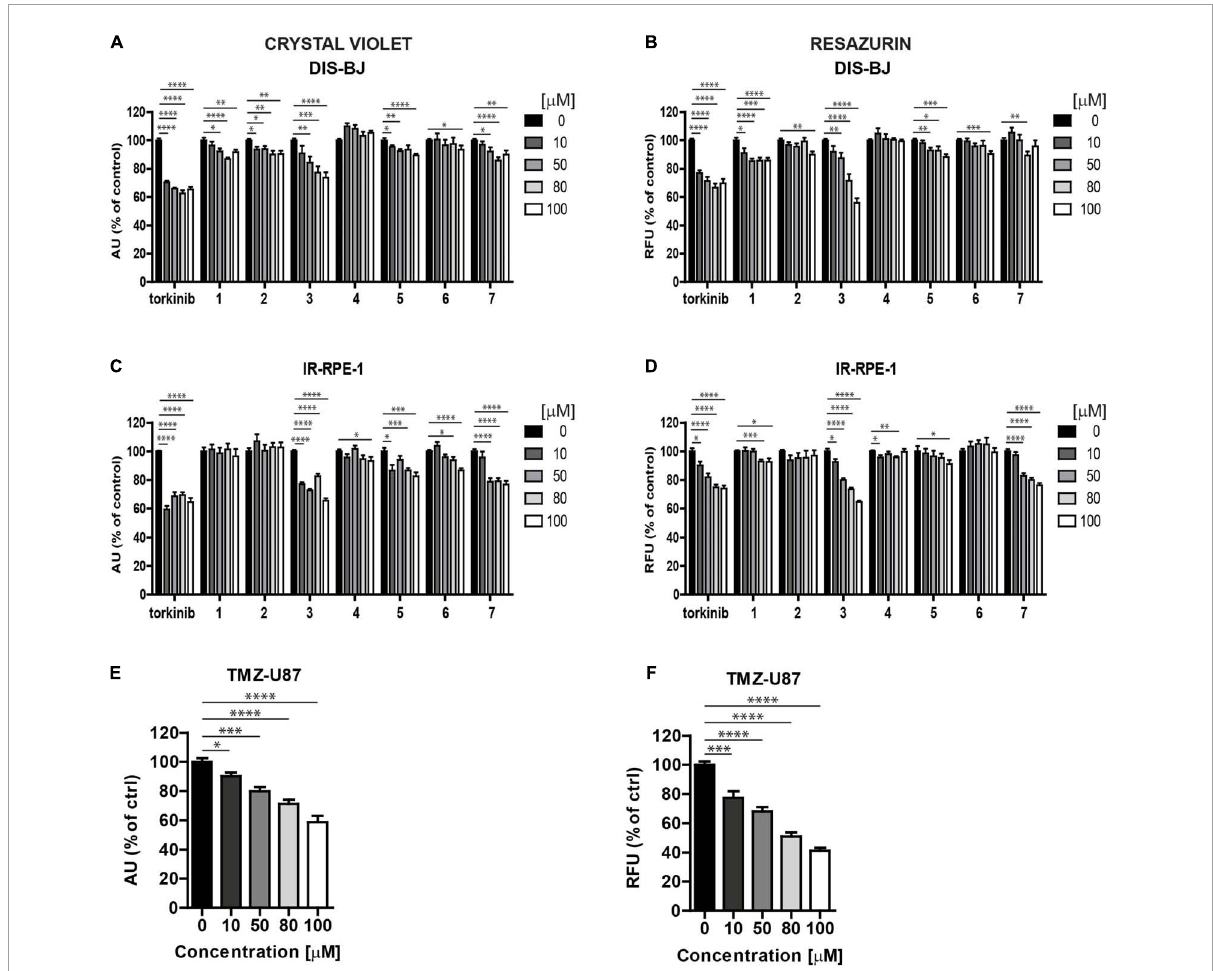
FIGURE6 Screening of new compounds on senescent cells. Ionizing radiation (IR)-induced RPE-1 (A,B) and docetaxel (DTX)-induced BJ (C,D) cells were exposed to compounds 1 – 7 in the concentration range of 0–100 µ M for 24 h. Torkinib served as a reference compound. Temozolomide (TMZ)-induced glioblastoma U87 cells (E,F) were exposed to compound 3 in the concentration range of 0–100 µ M for 24 h. The senescent cell response was detected by crystal violet (A,C,E) and resazurin (B,D,F) assays. The experiment was performed in triplicate. Data were normalized to untreated cells and plotted as mean ± SEM. Two-tailed Student’s t -test, ∗∗∗∗ p < 0.0001; ∗∗∗ p < 0.001; ∗∗ p < 0.01; ∗ p <